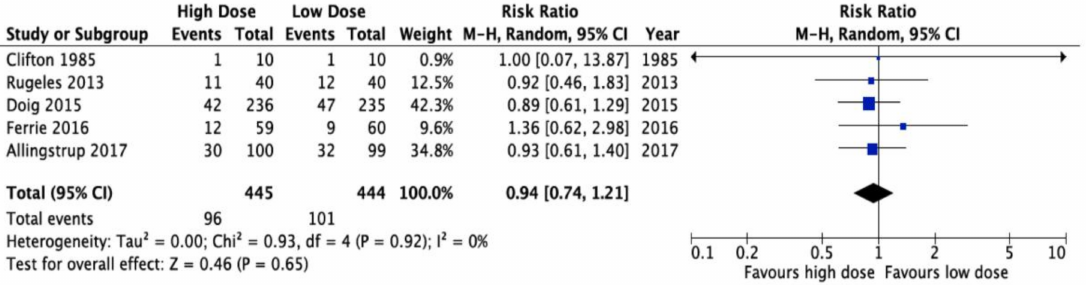
Figure 1. Meta-analysis of five randomized trials of high vs. low dose protein administration in the critically ill: effect on overall